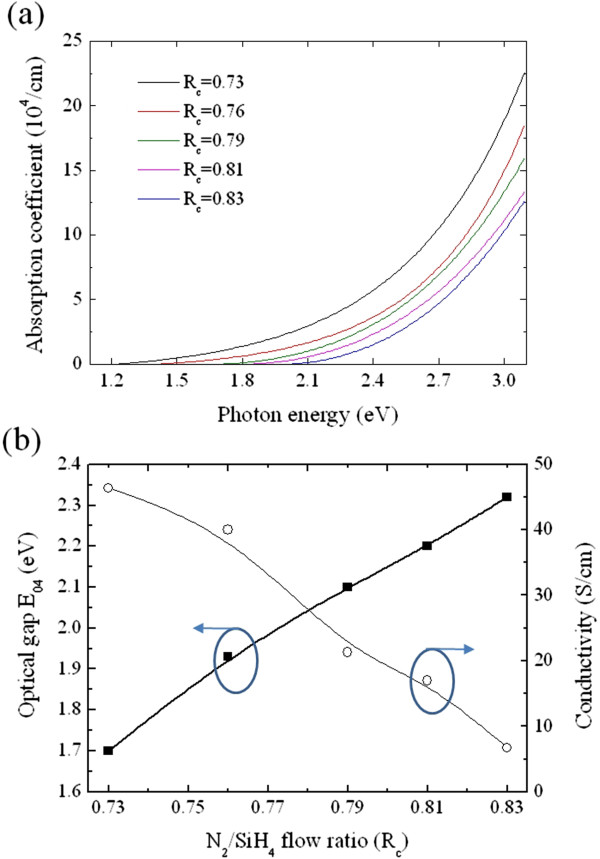
Optical and electrical properties of P-doped Si-NCs/SiNxfilms. (a) Absorption coefficients of the P-doped Si-NCs/SiNx films versus the incident photon energy. (b) Optical gap E04 and electrical conductivity of P-doped Si-NCs/SiNx films as a function of the Rc value.